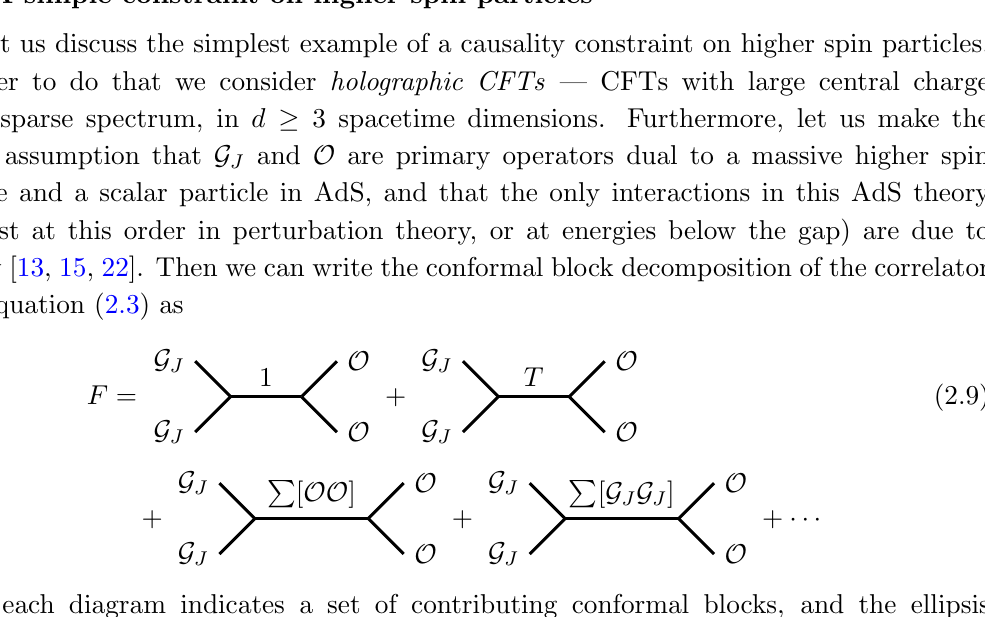
Figure 1 . Example of a Rindler symmetric four-point function. The operators over some regions in a Rindler reflection symmetric way as well. Note that this is just a schematic representation of the actual four-point function that we will use to derive the bound. In the actual correlator F , the operators ’s are smeared around an imaginary time G J